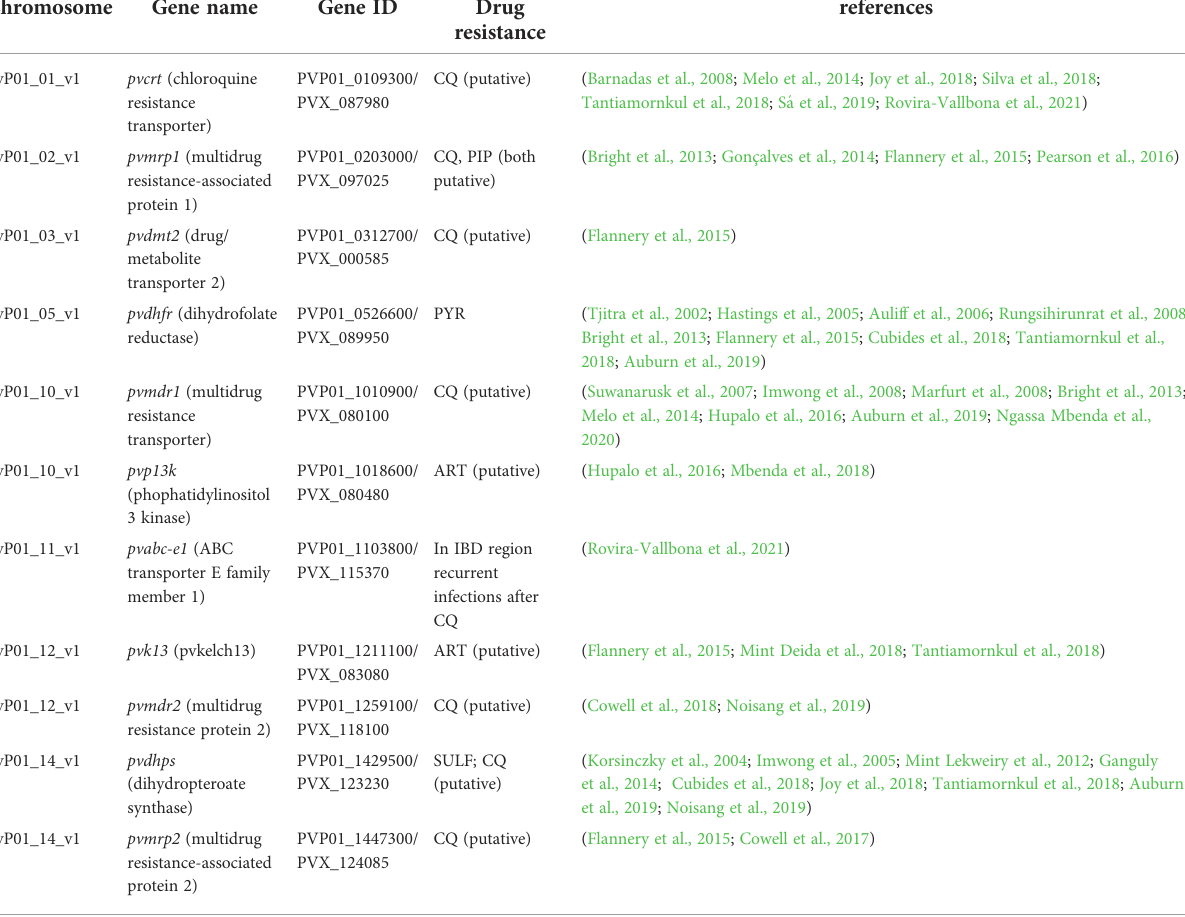
TABLE 1 List of potential drug resistance genes targeted in the Pv Ampliseq assay.